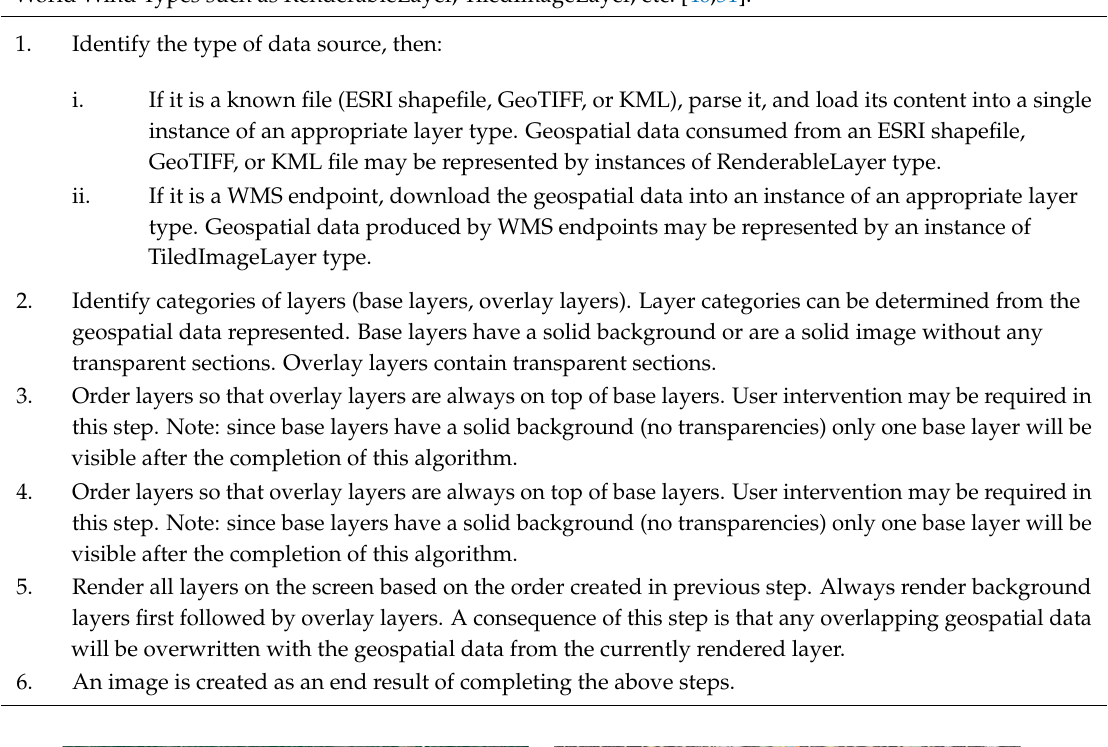
Algorithm 1: Algorithm for Graphical Aggregation and Fusion of Geospatial Data refers to Java and NASA World Wind Types such as RenderableLayer, TiledImageLayer, etc. [46,51].